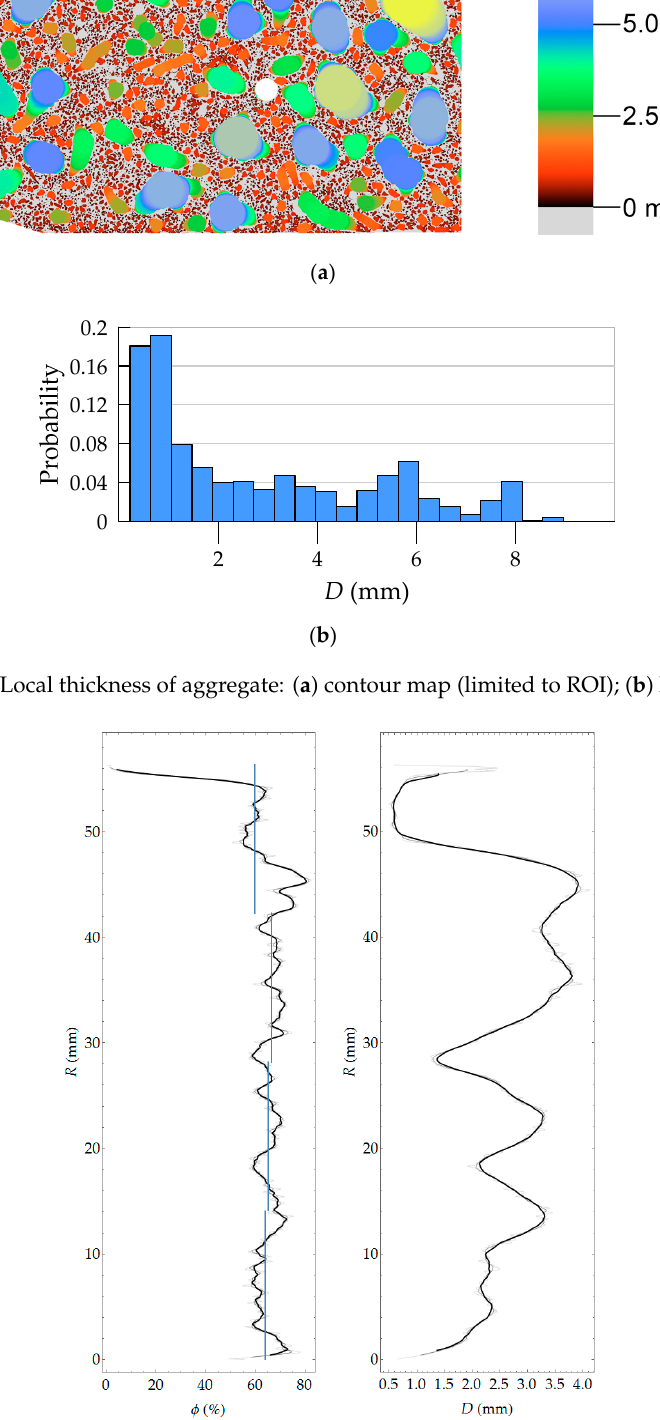
Figure 17. The sample attached to the holder and mounted in the chamber of X-ray scanner.